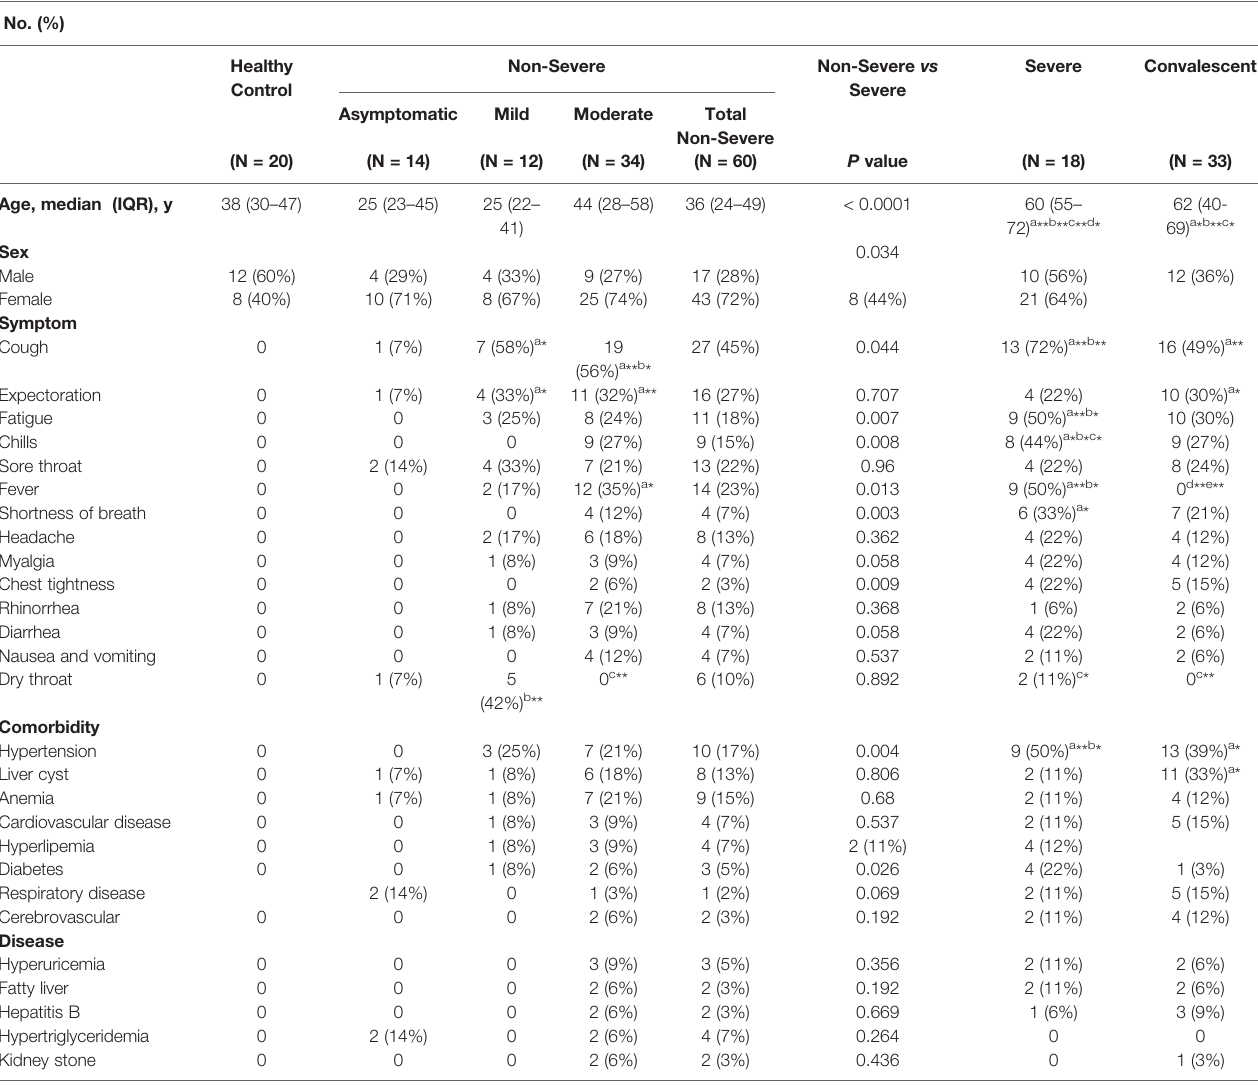
TABLE 1 | Demographics and baseline characteristics of patients infected with